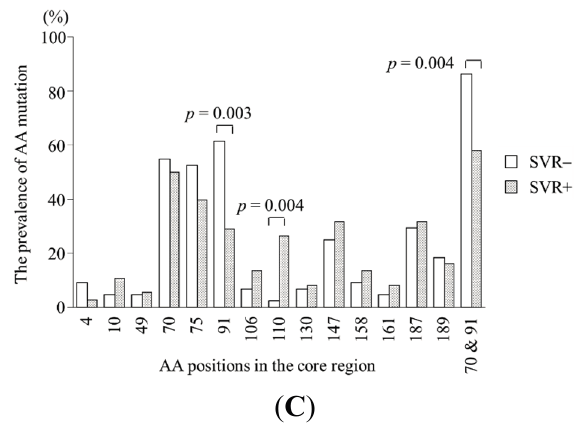
Figure 1. Specific amino acid patterns in the core region of hepatitis C genotype 1b patients.